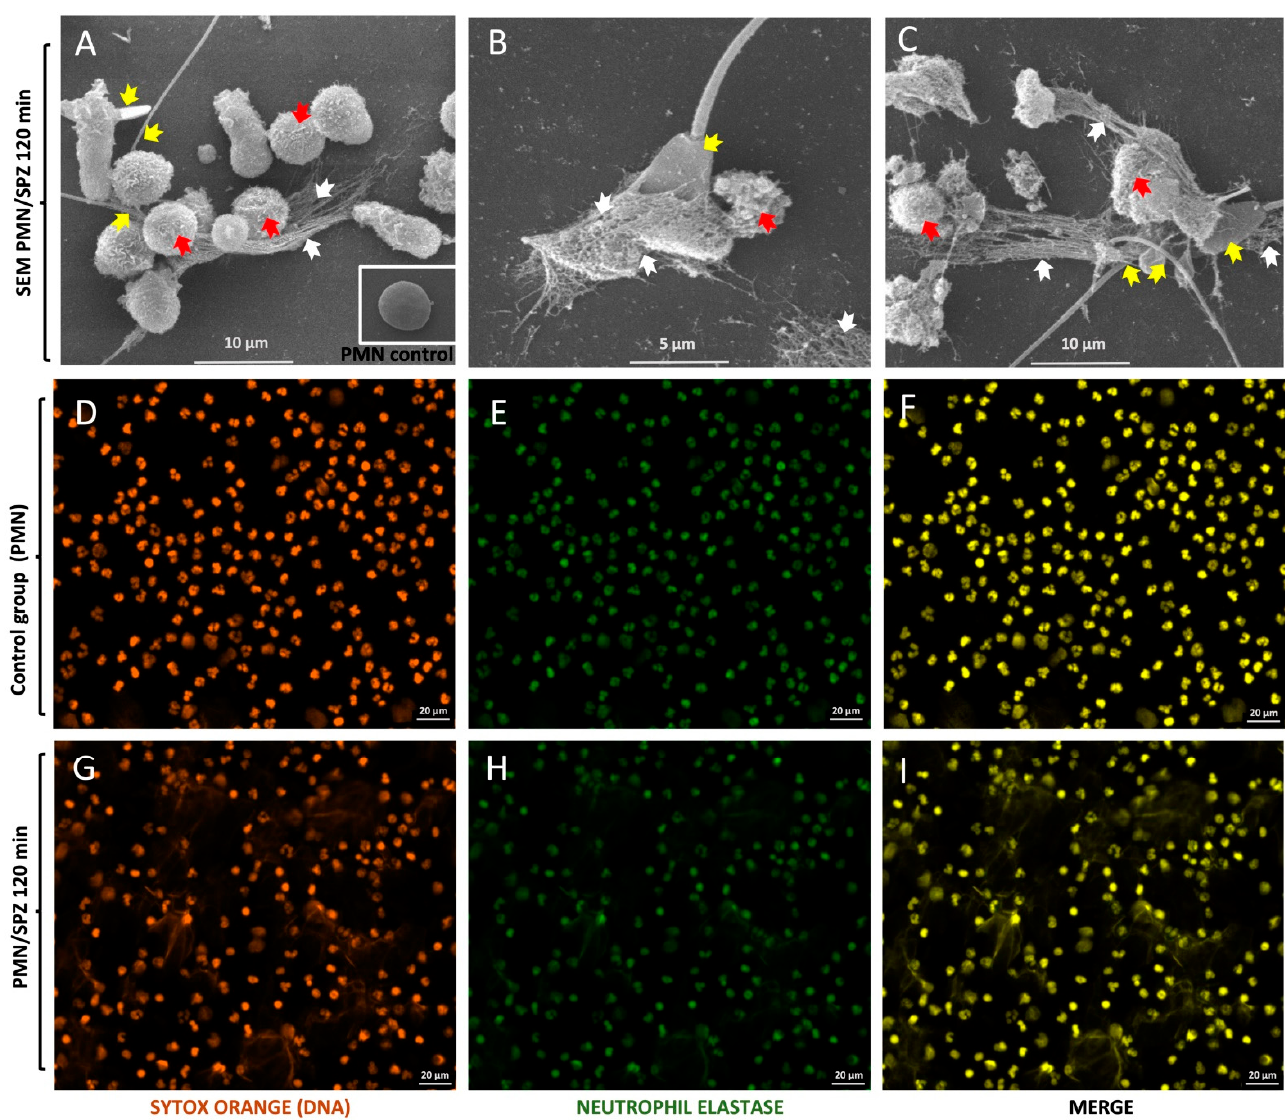
Figure 1. Visualisation of neutrophil extracellular traps (NETs) triggered by bovine spermatozoa using scanning electron microscopy (SEM) and immunofluorescence. Live bull sperm-induced NETs after 2 h of exposure to polymorphonuclear neutrophils (PMN) are shown. The SEM analysis and immunofluorescence of neutrophil elastase shows the activation of PMN in the presence of spermatozoa. The formation of NETs was triggered by spermatozoa, and spermatozoa were captured by NET structures. White arrows indicate NET structures, red arrows indicate PMN, and yellow arrows indicate sperm being trapped by NETs. Immunofluorescence images scale bars = 20 μ m. SEM image scale bars = 5 and 10 μ m.